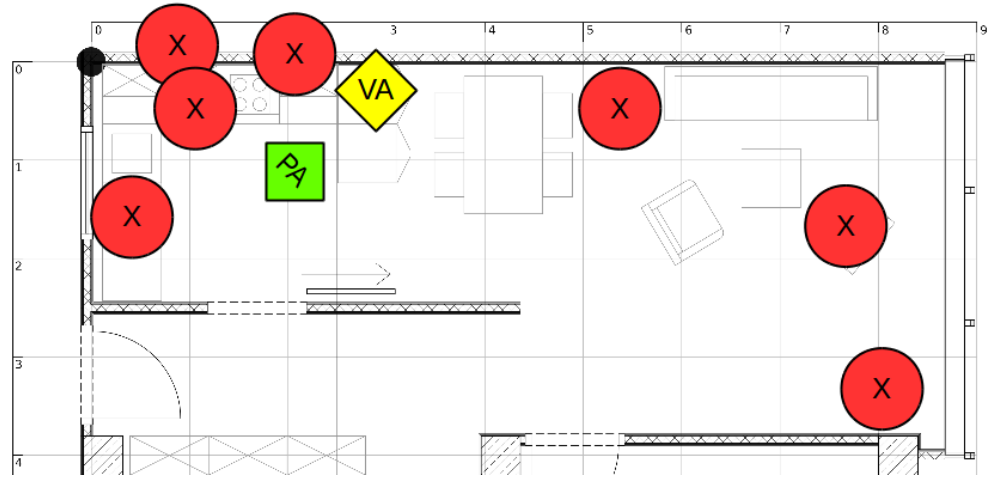
Figure 4. A 2D map of the smart home environment. (X) denotes hiding places of treats, (VA) the position of the screen with the virtual agent, and (PA) the initial position of the